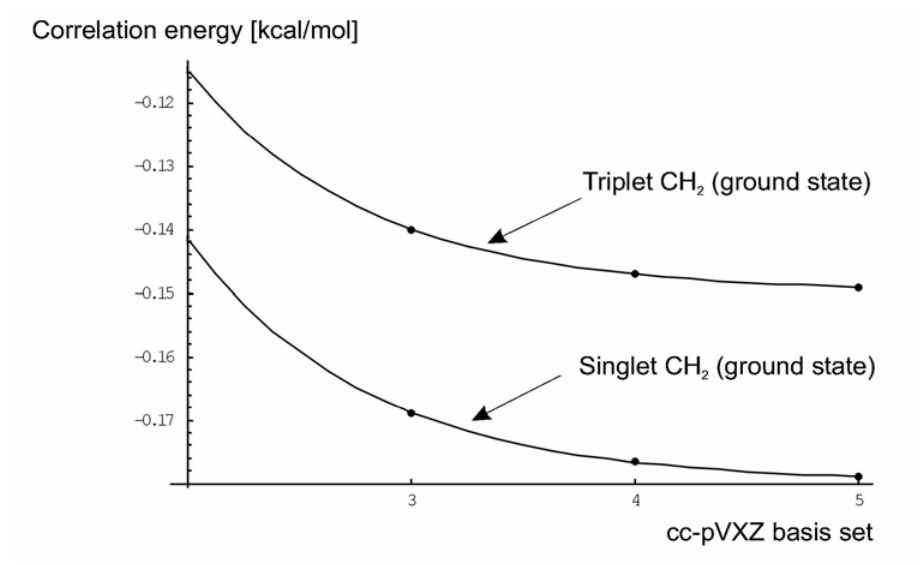
lowest state of CH 1